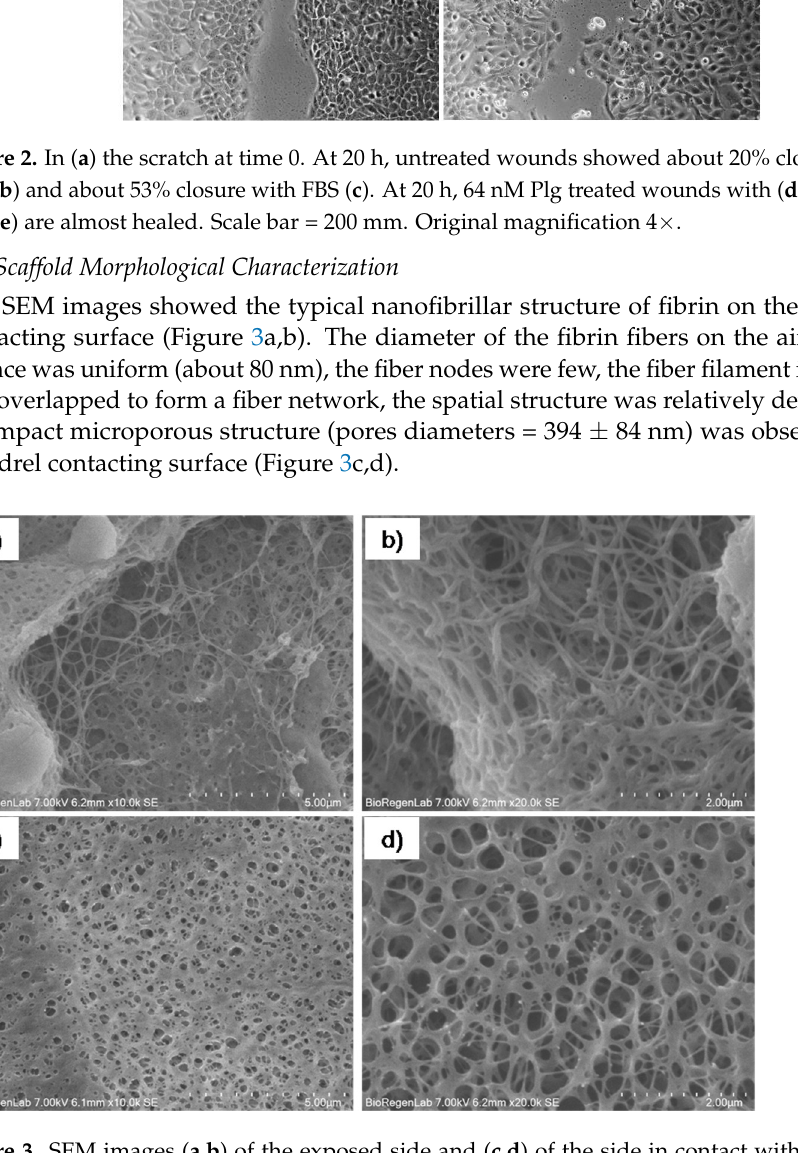
Figure 2. In ( a ) the scratch at time 0. At 20 h, untreated wounds showed about 20% closure without FBS ( b ) and about 53% closure with FBS ( c ). At 20 h, 64 nM Plg treated wounds with ( d ) and without FBS ( e ) are almost healed. Scale bar = 200 mm. Original magnification 4×.